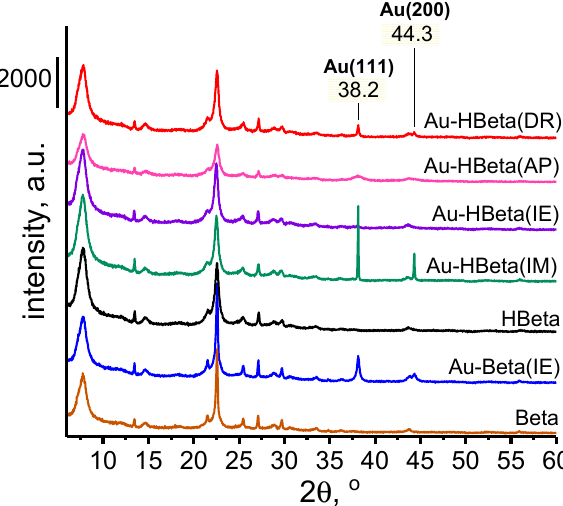
Figure 1. XRD patterns of zeolites. The peaks originating from metallic gold species were marked.